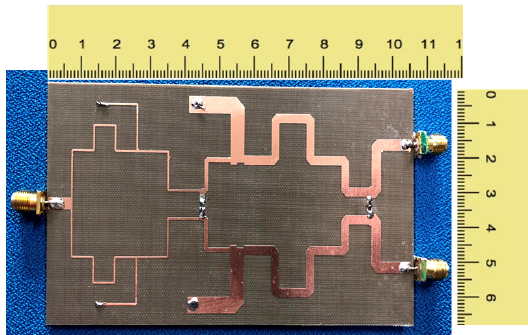
Figure 10. Simulated S-parameters for θ c = 65 ◦ .